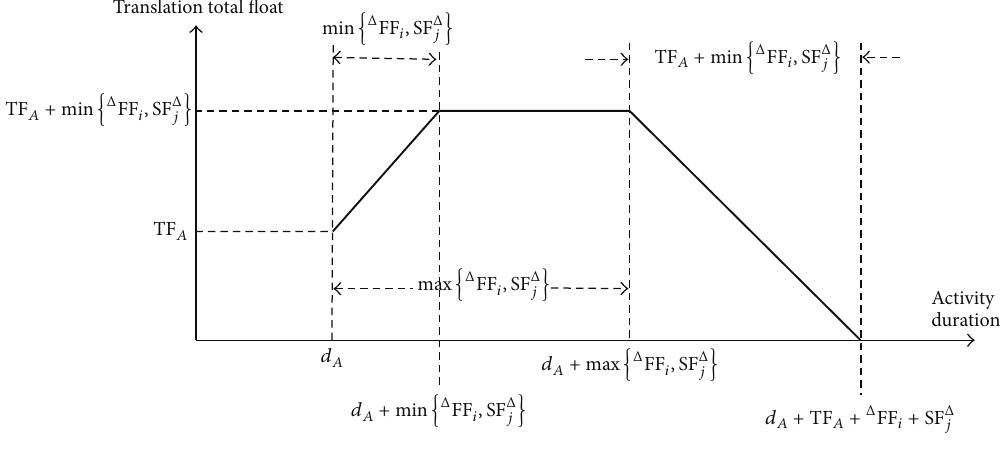
Figure 5: Curve chart of the translation total float when Δ FF 𝑖 > 0 and SF Δ 𝑗 > 0 .